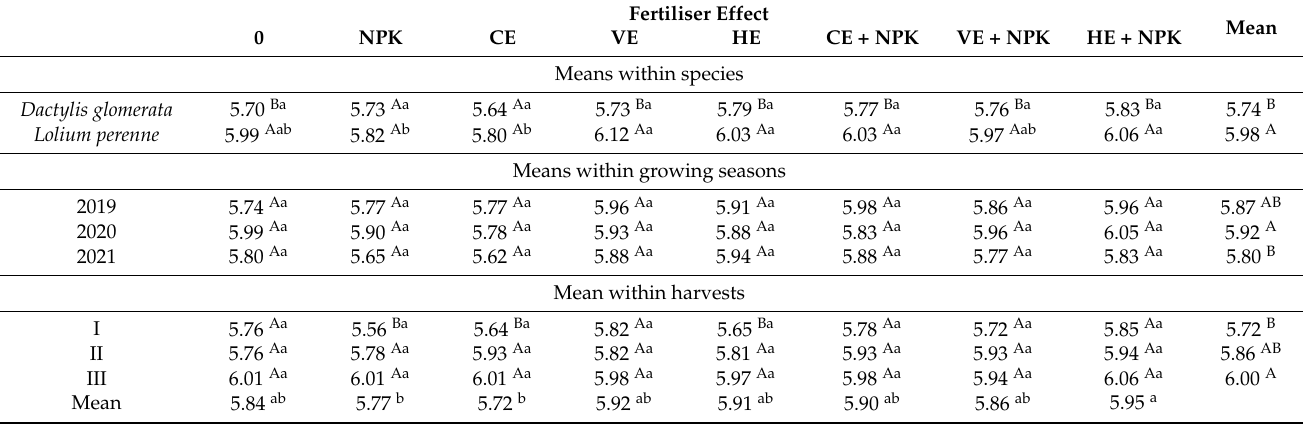
Table 4. Net energy of lactation of Dactylis glomerata and Lolium perenne in consecutive harvests and growing seasons (MJ · kg − 1